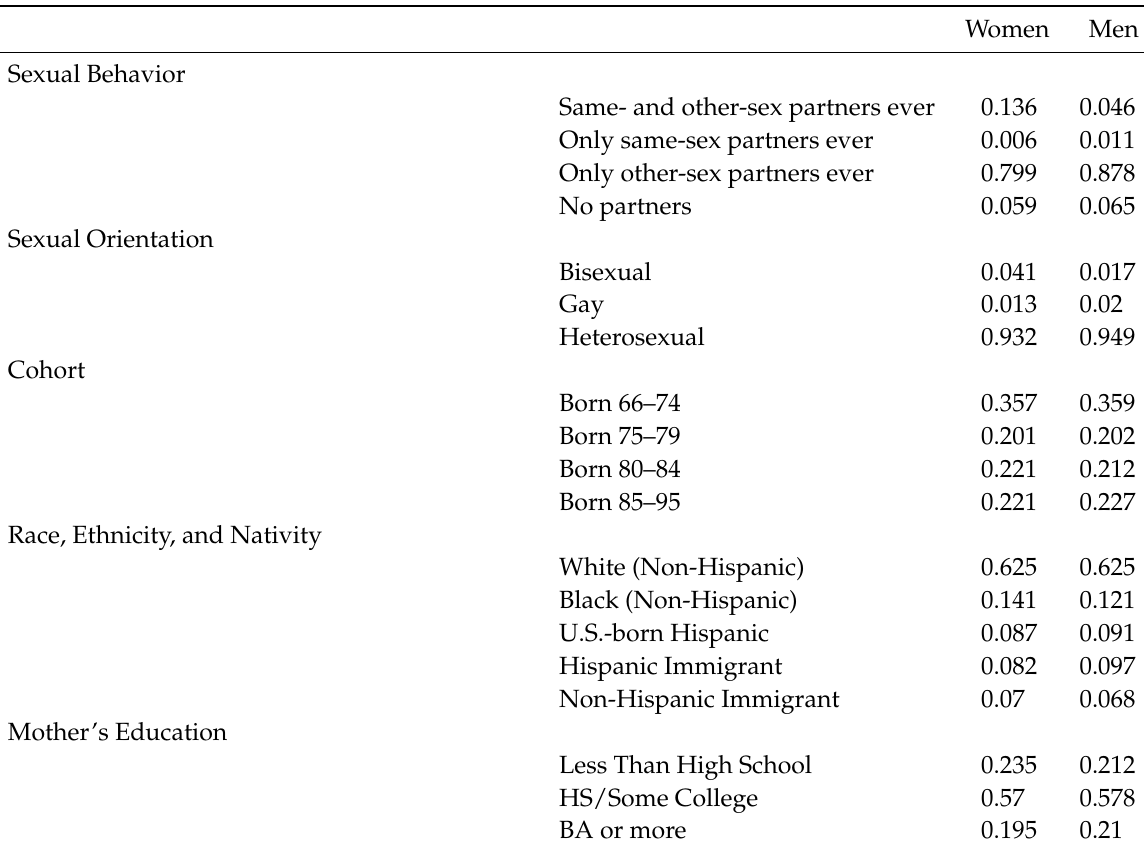
Table 1: Means by